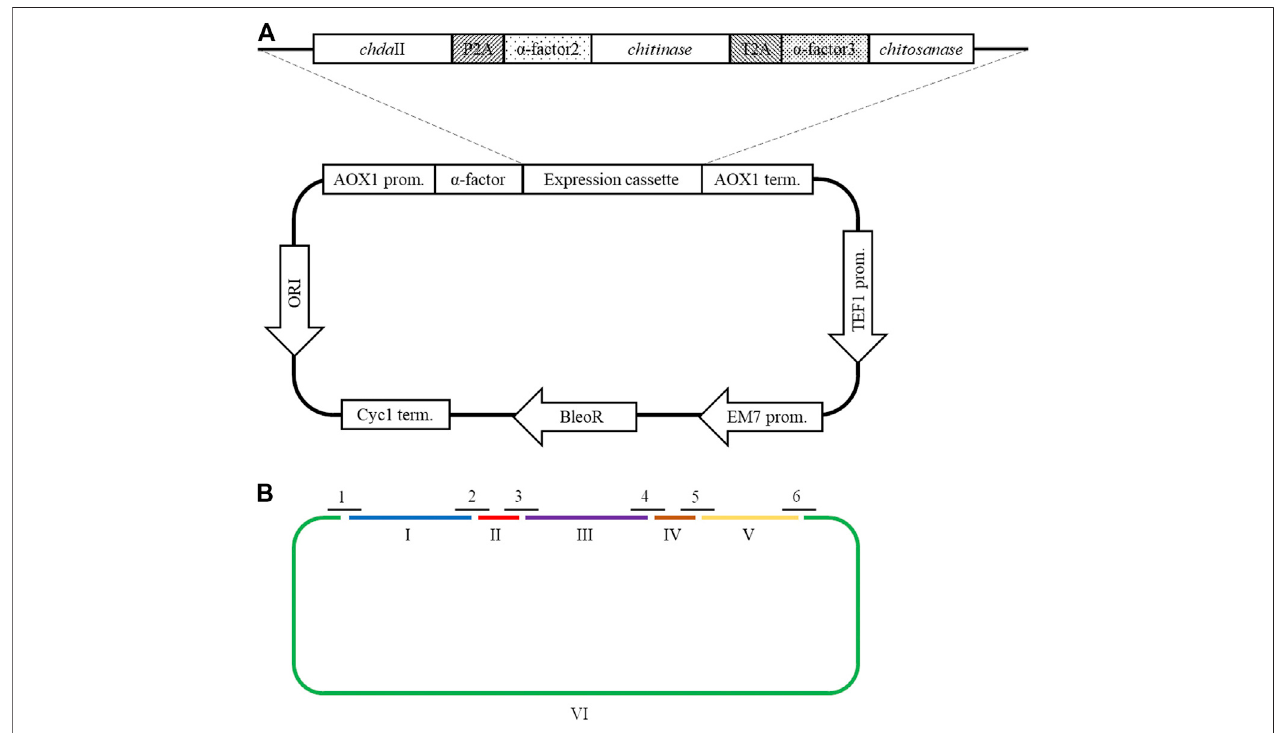
FIGURE1|(A) ThemapofthepCHITexpressionvectorandafragmentoftheexpressioncassette; (B) Simpli fi eddiagramofthesynthesisofapolycistronicvector pCHIT by use of LCR. 1-6 bridge sequences - black lines ( Supplementary Table S2 ); I-VI - vector components - colored lines ( Supplementary Table S1